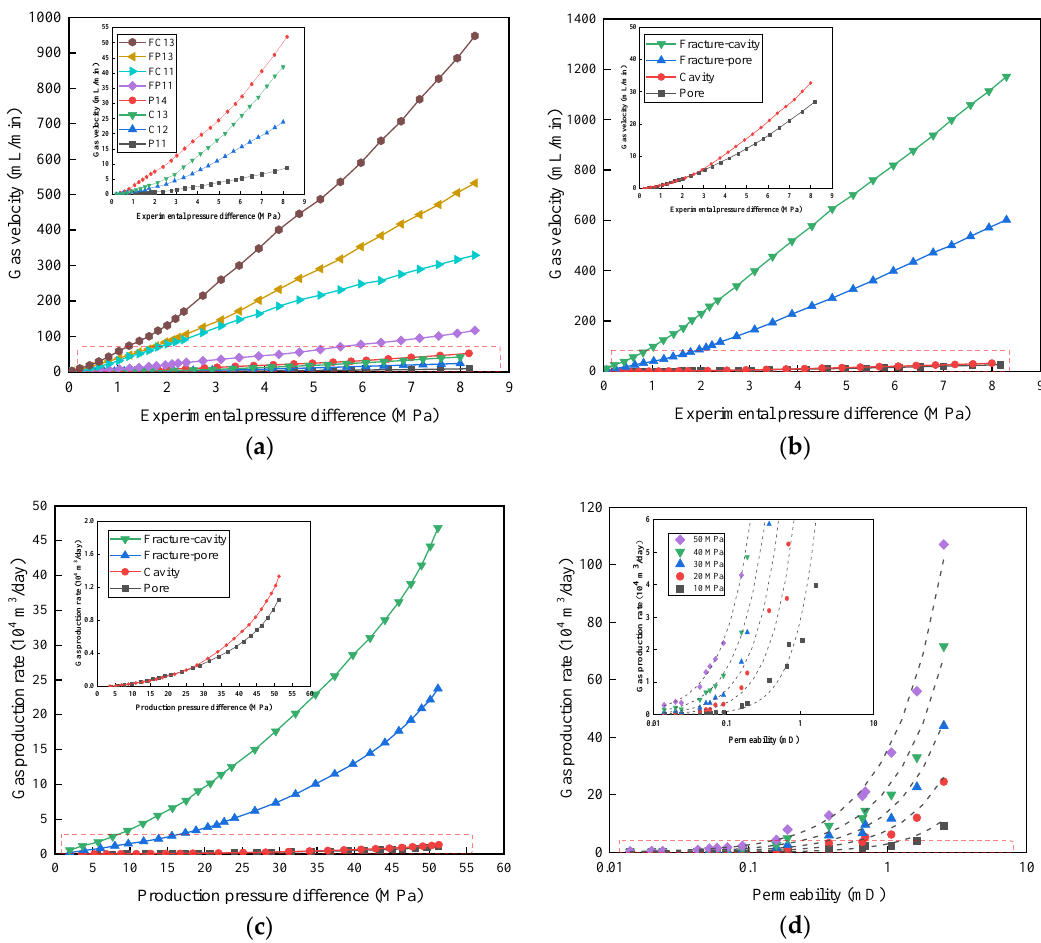
Figure 10. Gas flow and production rate characteristics of different types of reservoirs: ( a ) gas velocity; ( b ) average velocity; ( c ) average production rate; ( d ) production rate under different pressure differences.